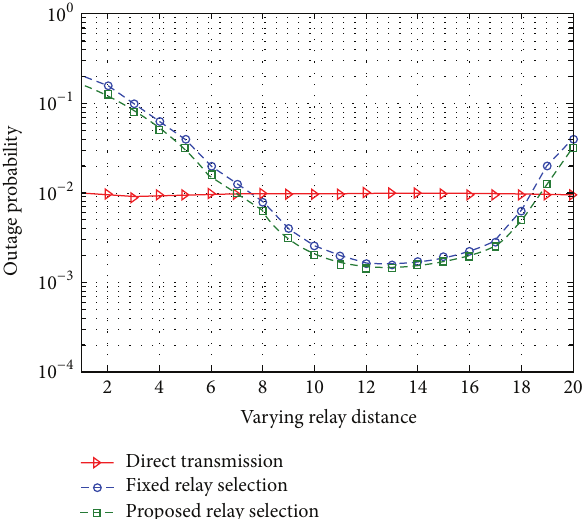
Figure 12: Outage probability with varying relay